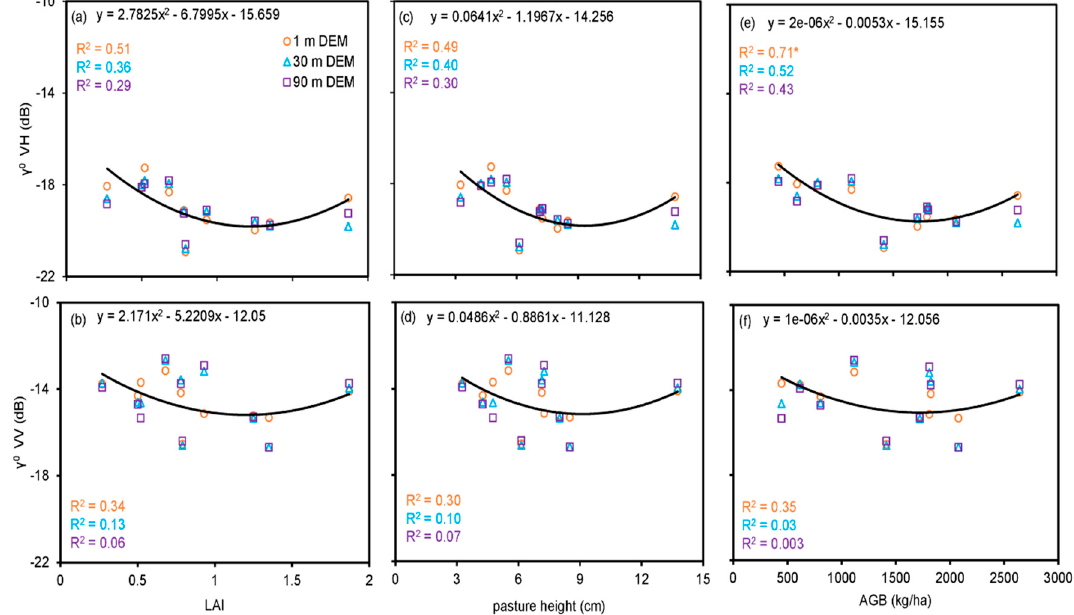
Figure 8. Relationship between the VH cross-polarisation and VV co-polarisation and biophysical variables; ( a , b ) leaf area index, ( c , d ) pasture height and ( e , f ) aboveground biomass. The parabola is a representation of the relationships observed for the 1 m DEM analysis only. The parabolas for 30 m and 90 m DEM analyses were not shown to preserve clarity of figures. The R 2 values are for the 1 m, 30 m and 90 m DEM analyses, respectively. * denotes significant relationship at 95% confidence level.